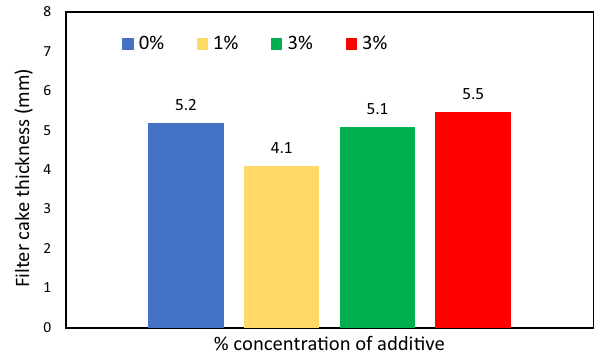
Fig. 14 Filter cake thickness as a function of additive concentration